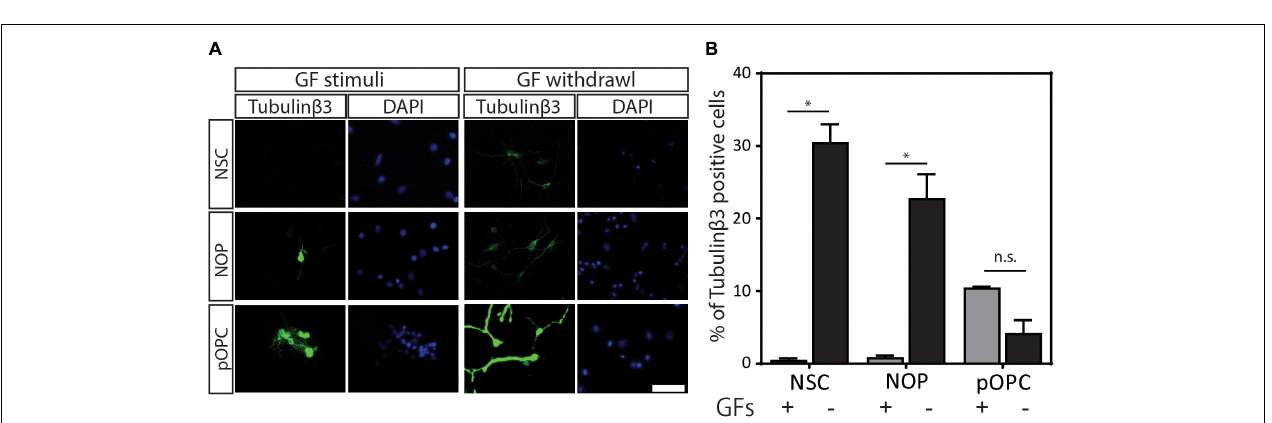
FIGURE 7 | Neural stem cell and NOP convert into GFAP + astrocyte-like cells. Representative images of immunofluorescent staining for GFAP protein in NSC (A) and NOP (B) after stimulation with human BMP-4 and LIF to promote astrocyte differentiation. Nuclei were counterstained with DAPI. White arrows indicate examples of DAPI + /GFAP + profiles. Scale bar: 20 µ m. (C) Percentage of DAPI + /GFAP + cells after BMP-4 and LIF treatment of NSC and NOP. Data represent means ± SD (bars) of three determinations.